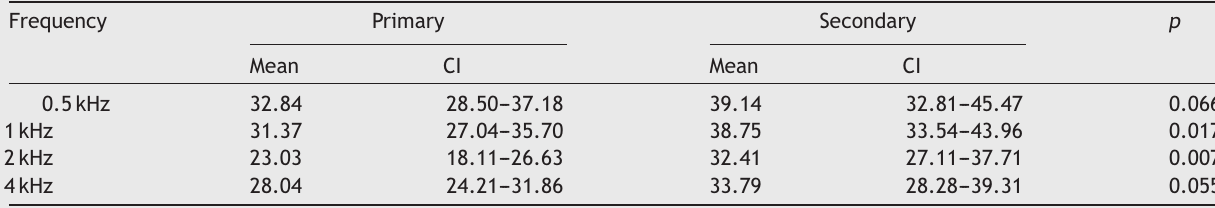
Mean gap (in dB) at different frequencies (in kHz) according to type of cholesteatoma.